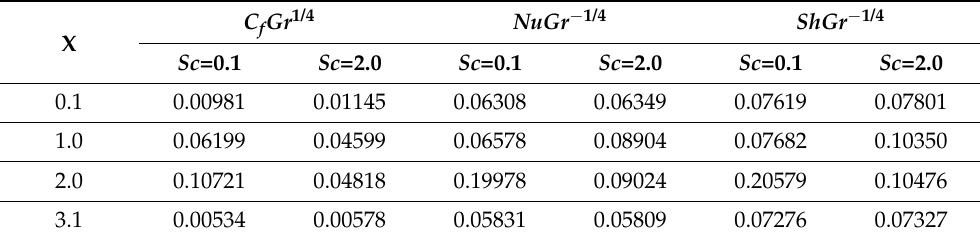
Table 1. Outcomes of the Schmidt number Sc on (a) the skin friction coefficient C f Gr 1/4 , (b) Nusselt NuGr − 1/4 , and (c) the Sherwood number ShGr − 1/4 when Nt = 0.2, Nb = 10.0, N = 1.1, and Pr = 7.0.